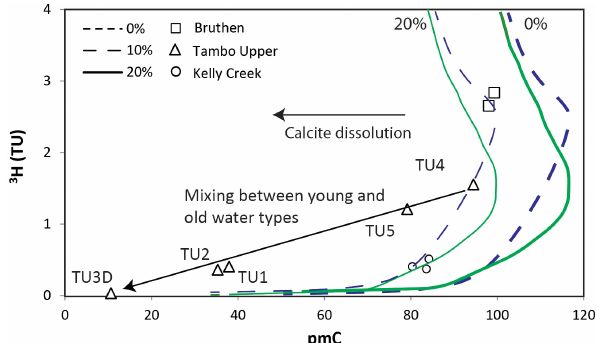
Figure 9. Co-variance of 3 H and 14 C in groundwater and that predicted by Eq. (1) (solid lines) for 0 and 20% DIC input from closed-system calcite dissolution. Dashed lines are the predicted co- variance of 3 H and 14 C from the renewal rate model of Le Gal La Salle et al.